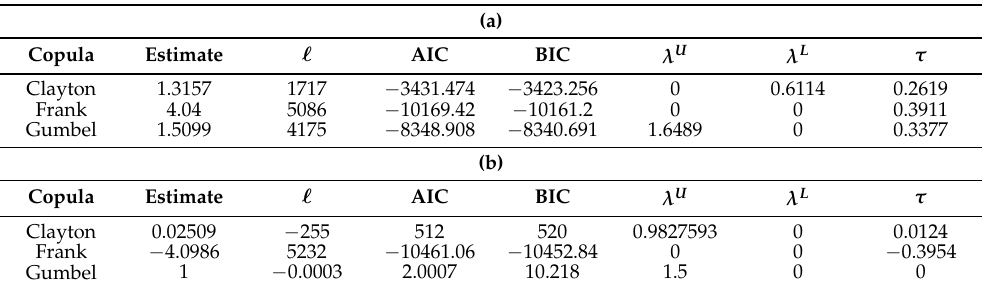
Table 6. ( a ) Parameter estimation for the Archimedean copula functions of GHI against temperature. ( b ) Parameter estimation for the Archimedean copula functions of GHI against RH.